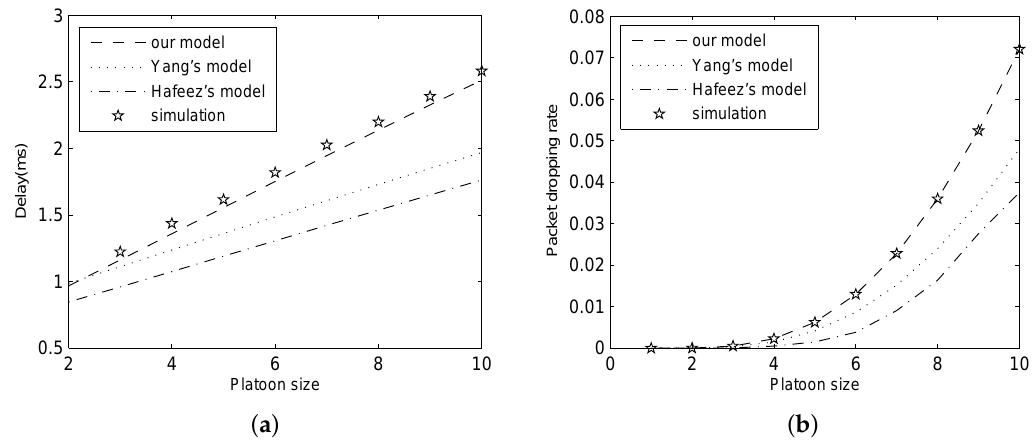
Figure 5. Results for different analytical models: ( a ) delay; and ( b ) packet dropping rate.